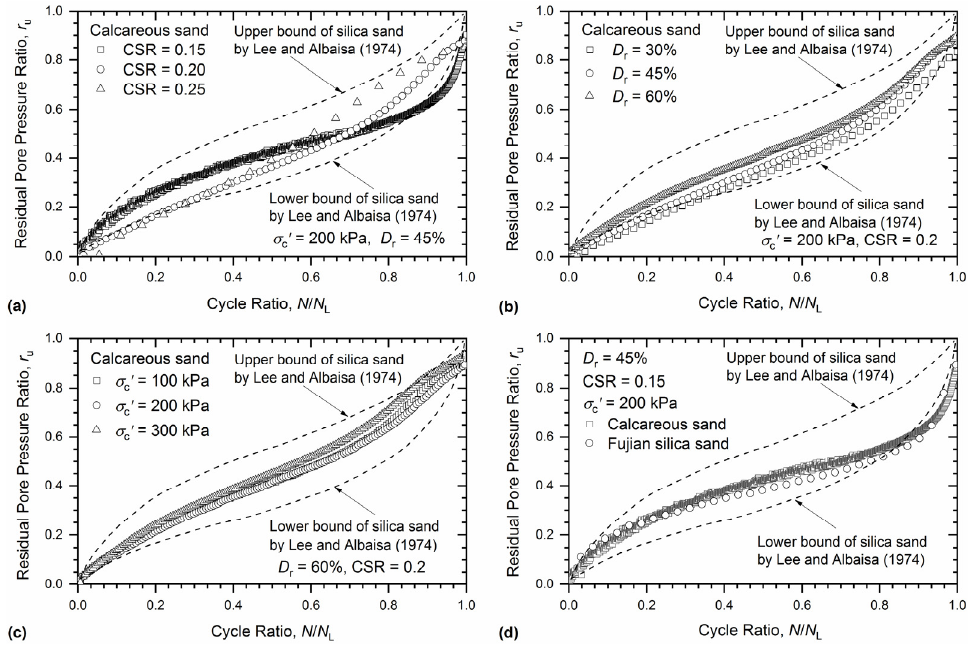
Figure 6. Comparison of residual pore pressure ratio versus cycle ratio: ( a ) calcareous sand with different cyclic stress ratios, ( b ) calcareous sand with different relative densities, ( c ) calcareous sand with different effective confining pressures, ( d ) calcareous sand and Fujian silica sand with the same loading conditions.